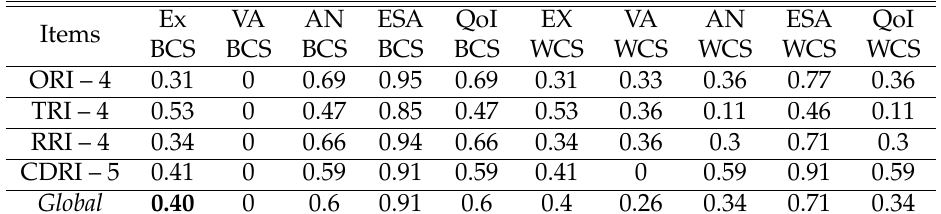
Table 5: The ranges of the predicates ori – 4 , tri – 4 , rri – 4 , and cdri – 5 , which were determined according to an employee’s answers to the ORI – 4 , TRI 4 – 4 , RRI – 4 , and CDRI –